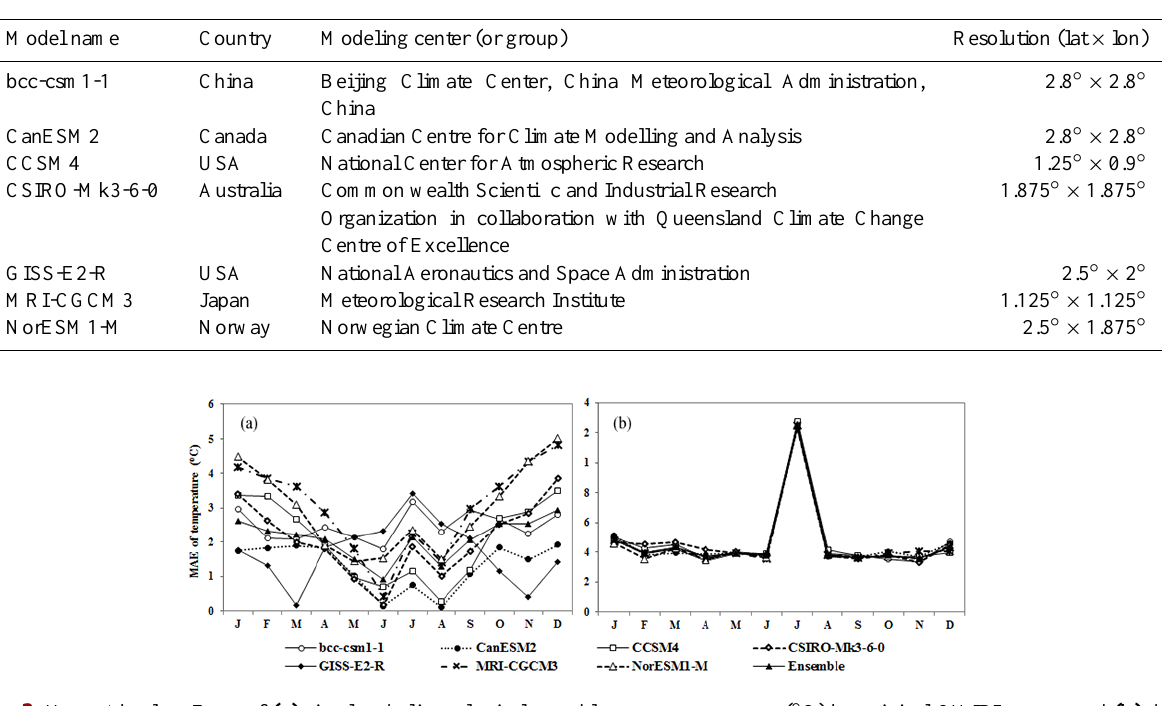
Figure 2. Mean Absolute Error of (a) simulated climatological monthly mean temperature ( ◦ C) by original CMIP5 output and (b) down- scaled models in China from 1950 to 1999.